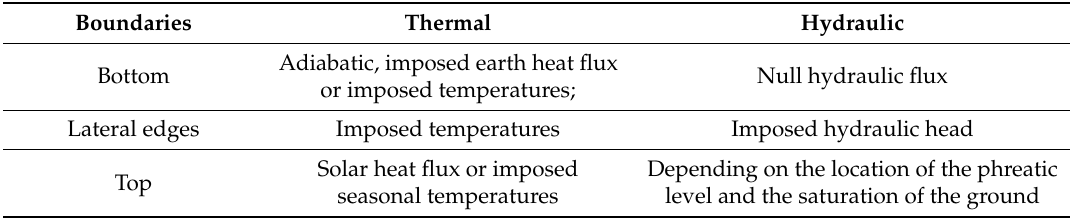
Table 1. Thermal and hydraulic boundary